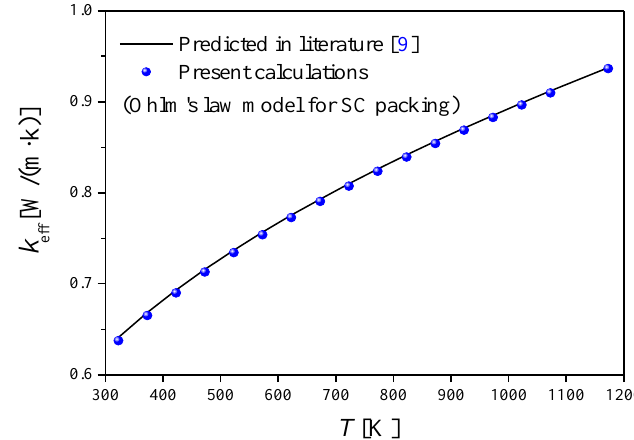
Figure 6. The effective thermal conductivities of SC packing calculated with the thermal resistance network of the Ohm’s law model.